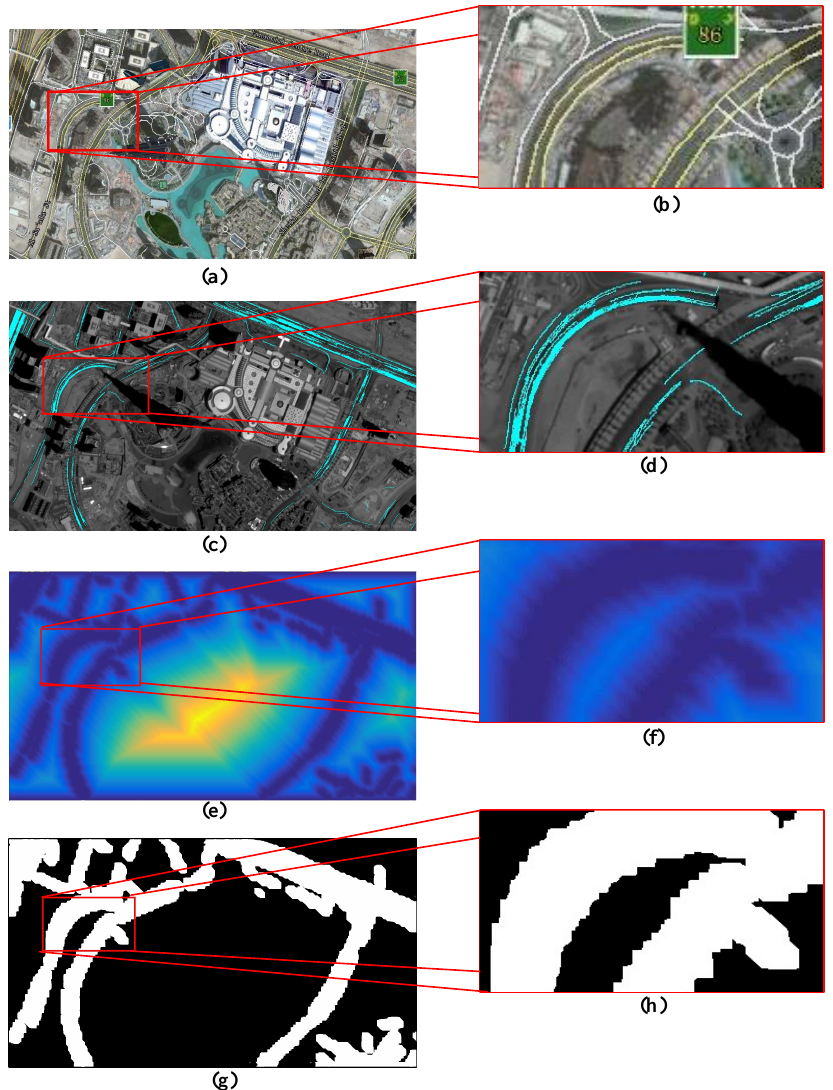
Figure 4. The main process result of building motion heat map. ( a ): real scenario captured by Google Earth; ( b ): partially enlarged image of ( a ); ( c ): accumulated trajectory image; ( d ): the partially enlarged image of ( b ); ( e ): the motion heat map; ( f ): the partially enlarged image of ( e ); ( g ) segmented result of motion heat map; and ( h ): the partially enlarged image of ( g